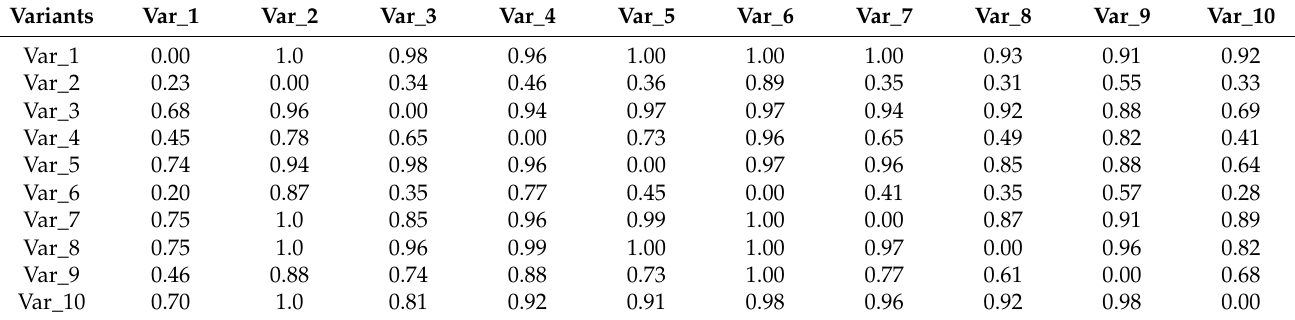
Table 11. Concordance matrix values from the point of view of the surveyed women.